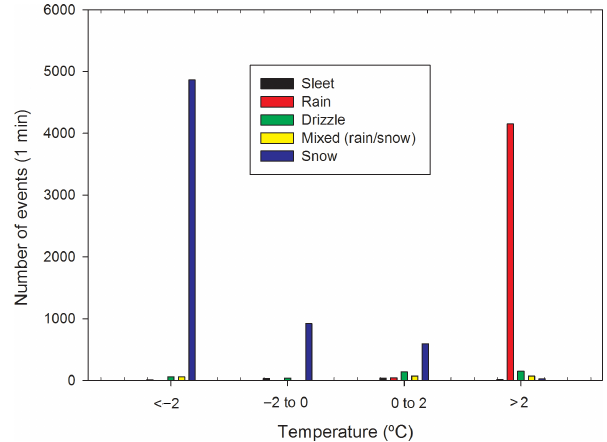
Figure 4. Frequency distribution of precipitation type binned by temperature using 1min data derived from the